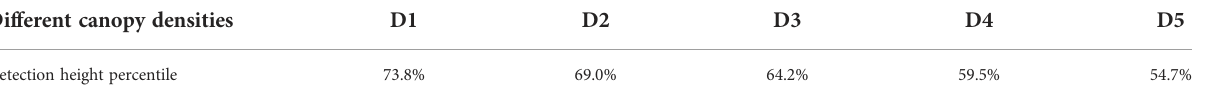
TABLE 6 Selection of height percentile for different canopy densities. Different canopy densities Detection height